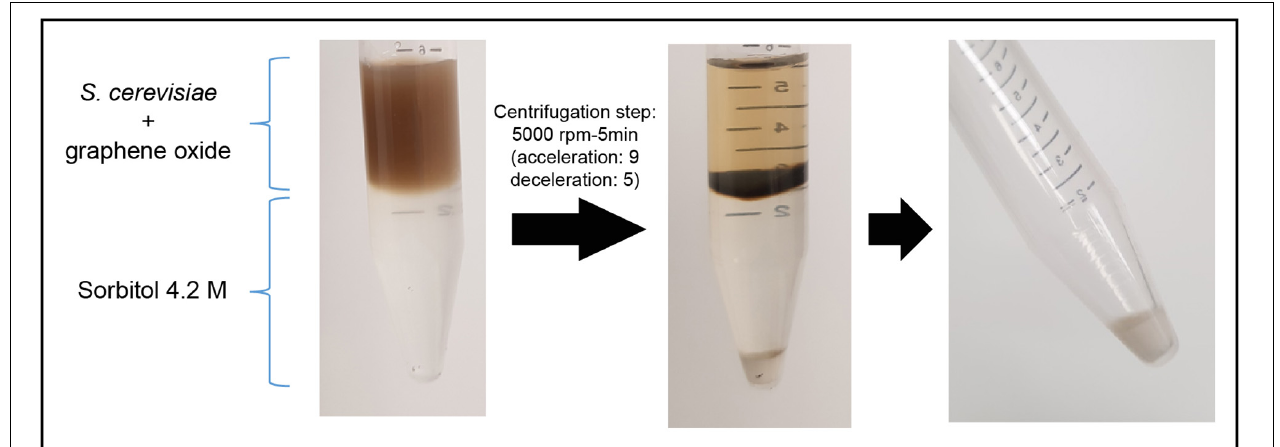
FIGURE 1 | S. cerevisiae cells separation from graphene oxide through density gradient centrifugation.